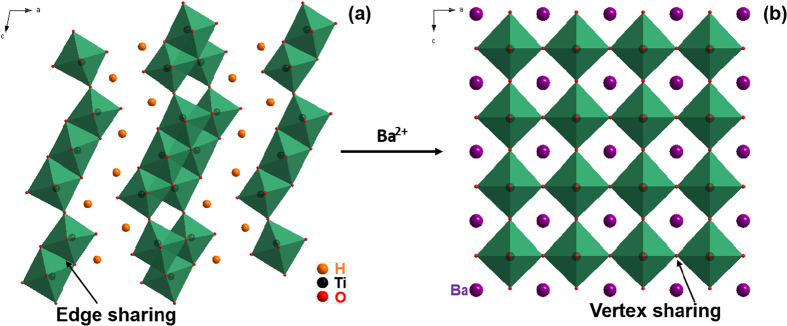
Schematic diagrams of the crystalline structures of (a) H2Ti3O7 and (b) BaTiO3.